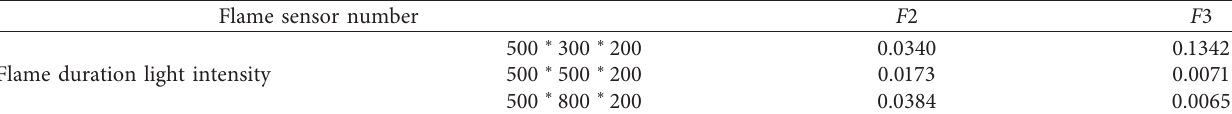
Figure 11: Experimental flame duration light intensity information of cavity with different widths. (a) 500 ∗ 300 ∗ 200. (b) 500 ∗ 500 ∗ 200. (c) 500 ∗ 800 ∗ 200. Table 2: Experimental flame duration light intensity of cavity with different